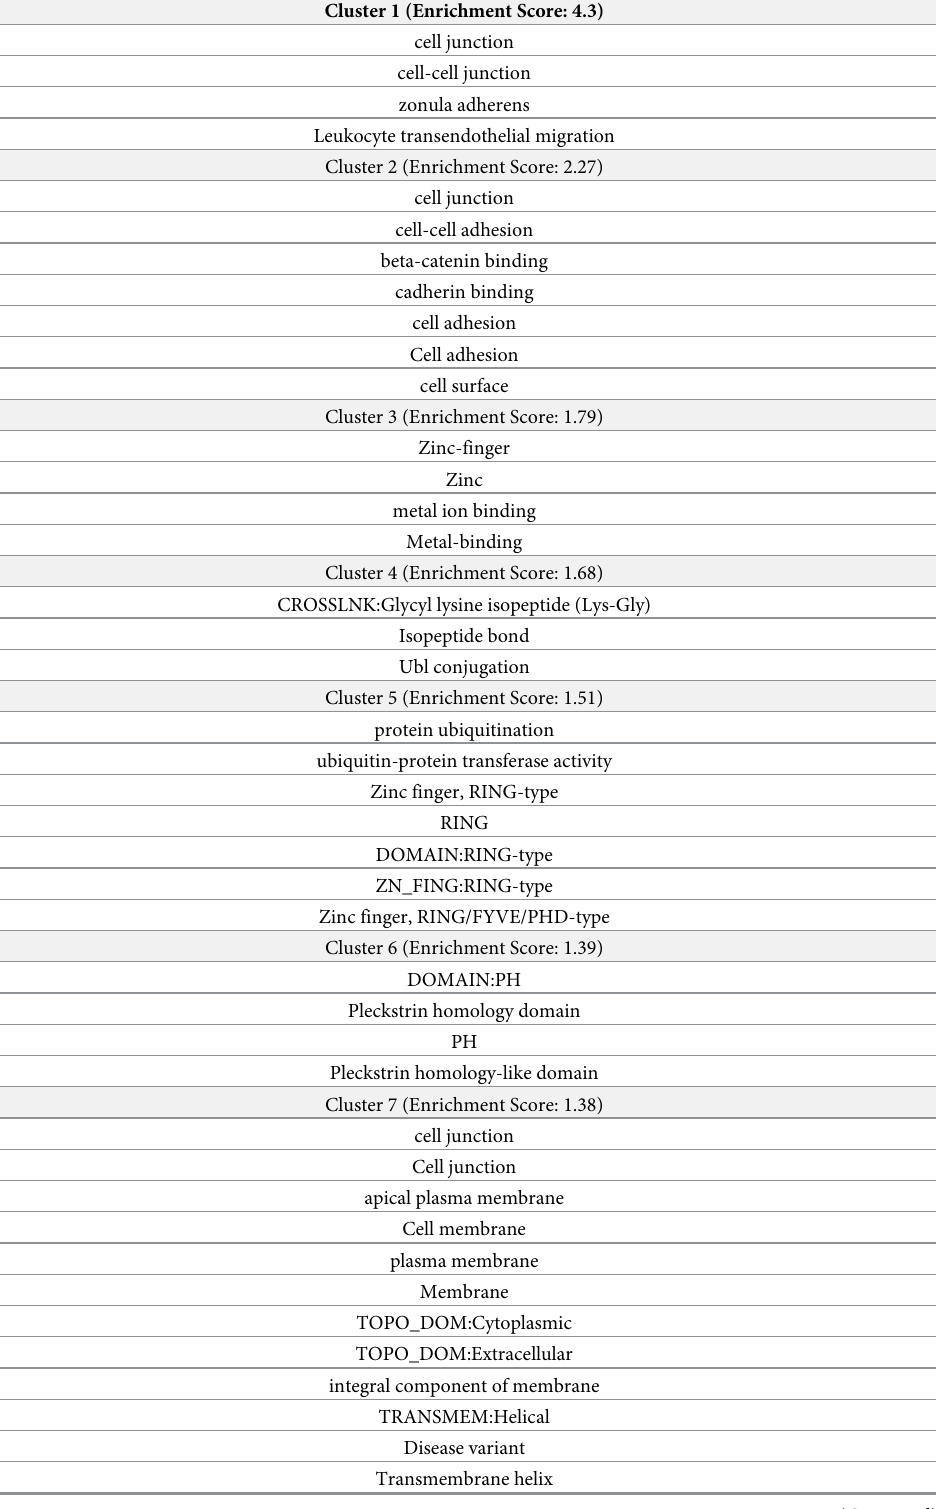
Table 2. Functional annotation of top genes positively associated with MYO5B in